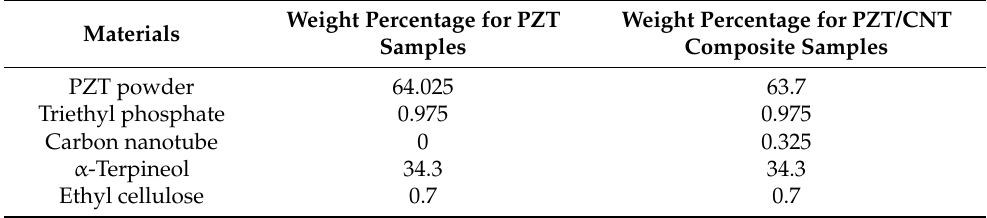
Table 1. Composition of the